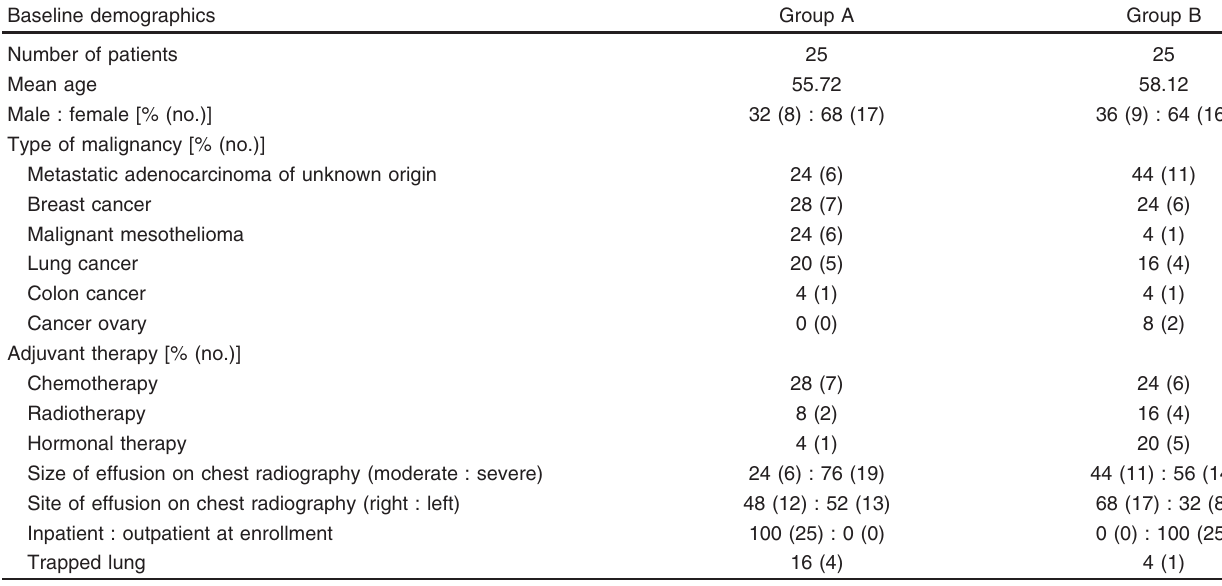
Table 1 Baseline demographic data for 50 patients with malignant pleural effusion Baseline demographics